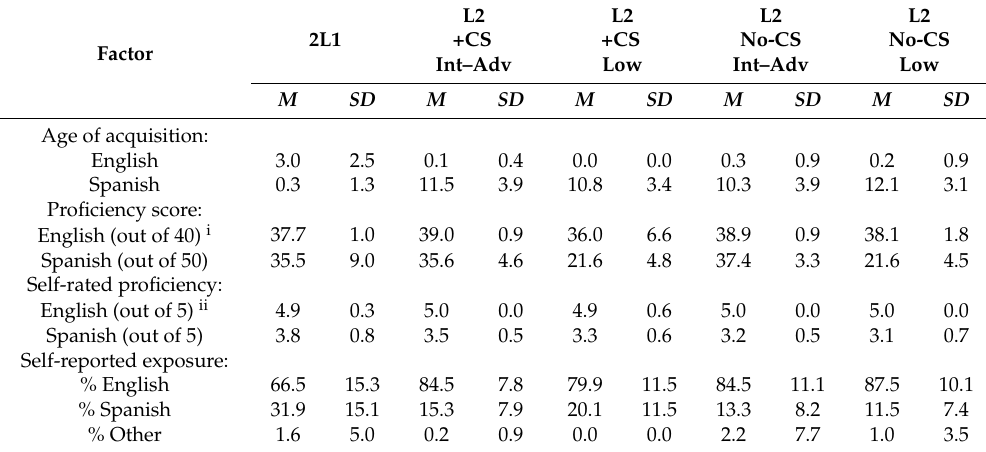
Table 3. Overview of